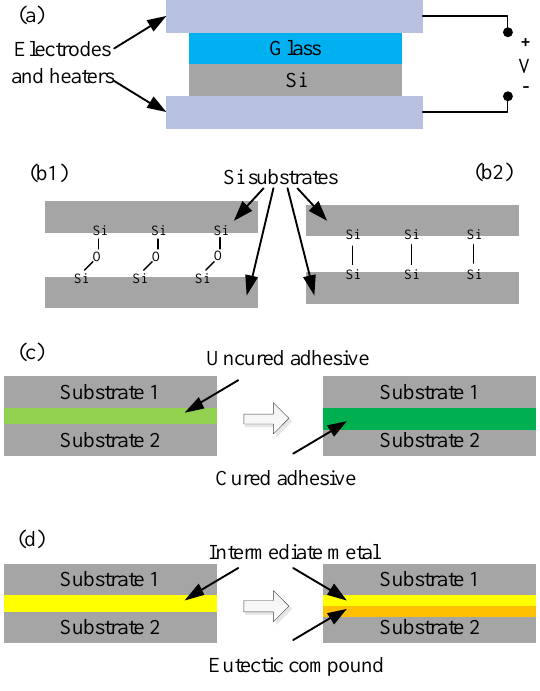
Figure 7. Schematic of: ( a ) Anodic bonding technique to bond glass and Si substrates; ( b ) Hydrophilic and hydrophobic bonding; ( c ) Adhesive bonding; ( d ) Eutectic